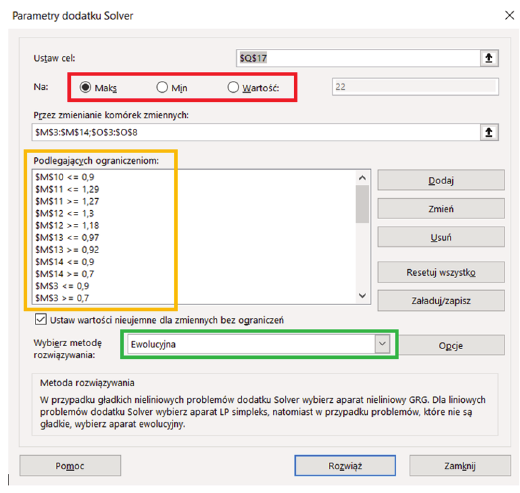
Fig. 1. View of the Solver add-in (print screen in